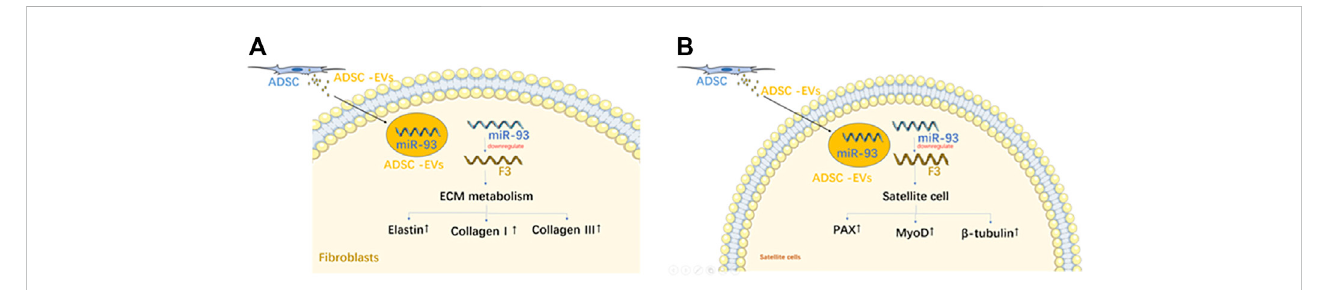
The mechanism of EVs from ADSC on fi broblasts (A) ; The mechanism of EVs from ADSC on satellite cell (B) .